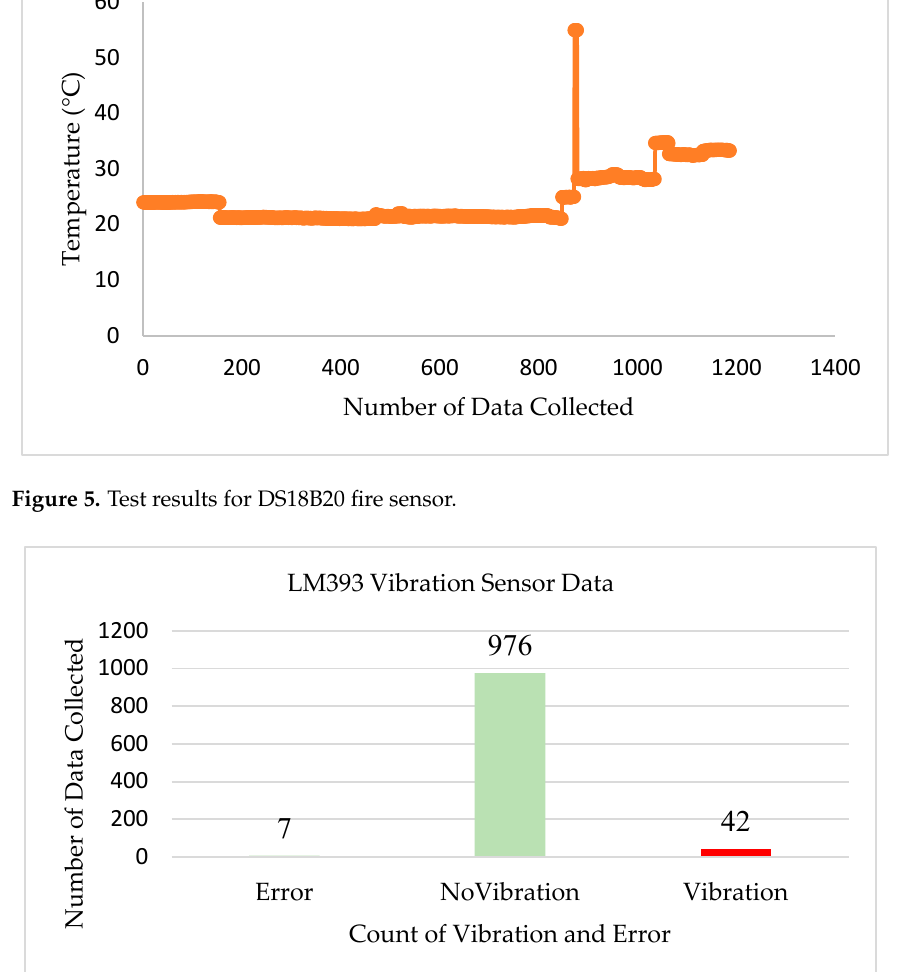
Figure 5. Test results for DS18B20 fire sensor.